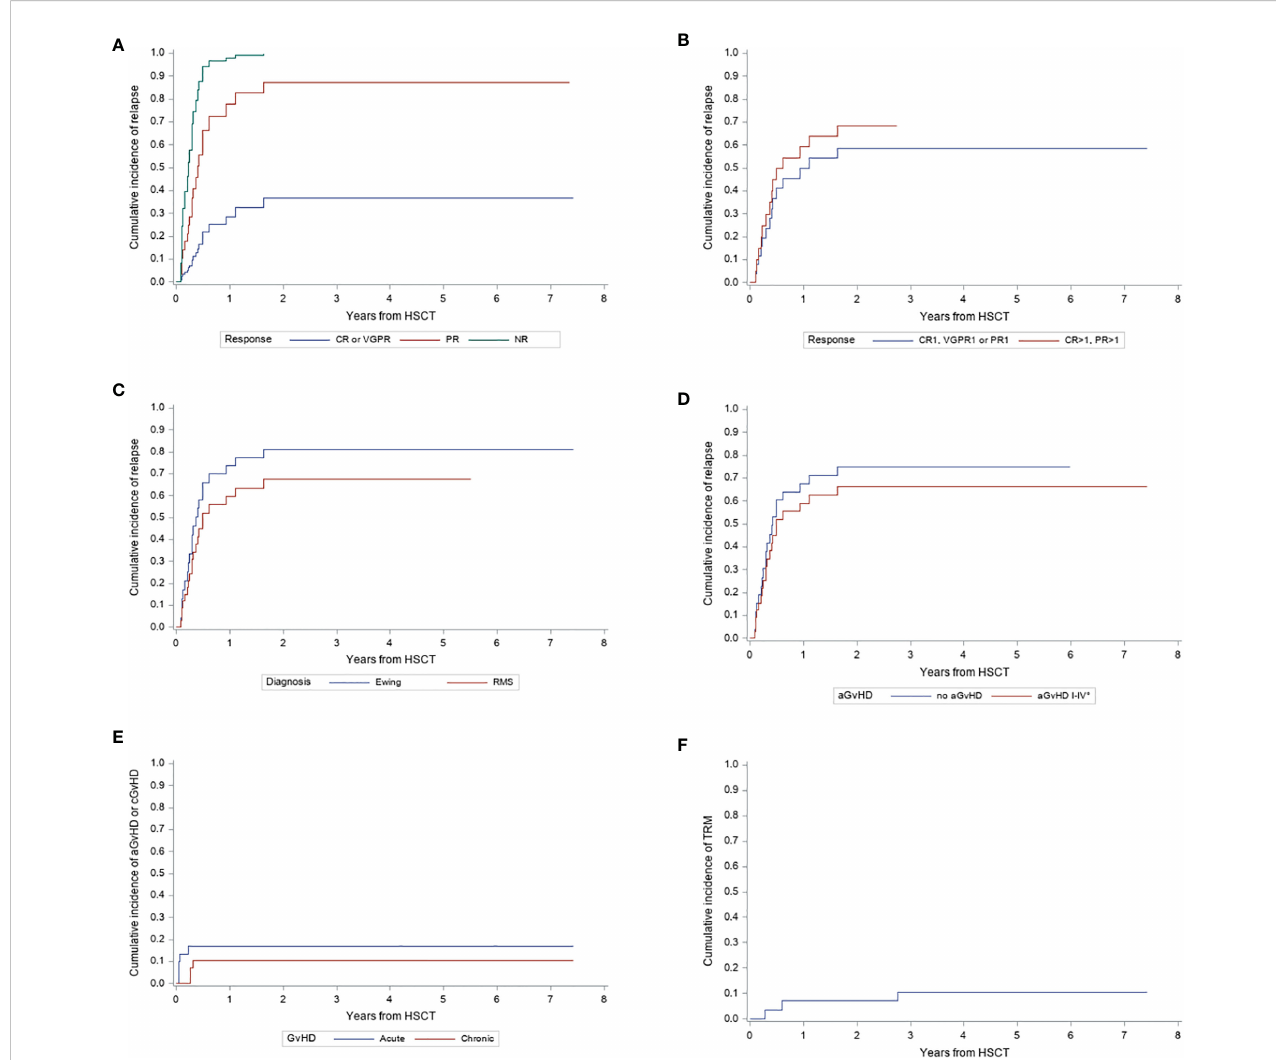
FIGURE 2 Cumulative Incidence (CI) of relapse, GvHD and transplant related mortality from haploidentical HSCT. (A) CI of relapse in patients who reach CR or VGPR after pre-transplant therapy compared to patients with either PR or NR. (B) CI of relapse in patients achieving fi rst CR, VGPR or PR pre-transplant compared to patients in CR or PR who were transplanted after relapse. (C) CI of relapse in patients with Ewing Sarcoma or Rhabdomyosarcoma. (D) CI of relapse according to occurrence of aGvHD °I-IV or no aGvHD. (E) CI of aGvHD °II-IV and cGvHD. (F) CI of transplant related